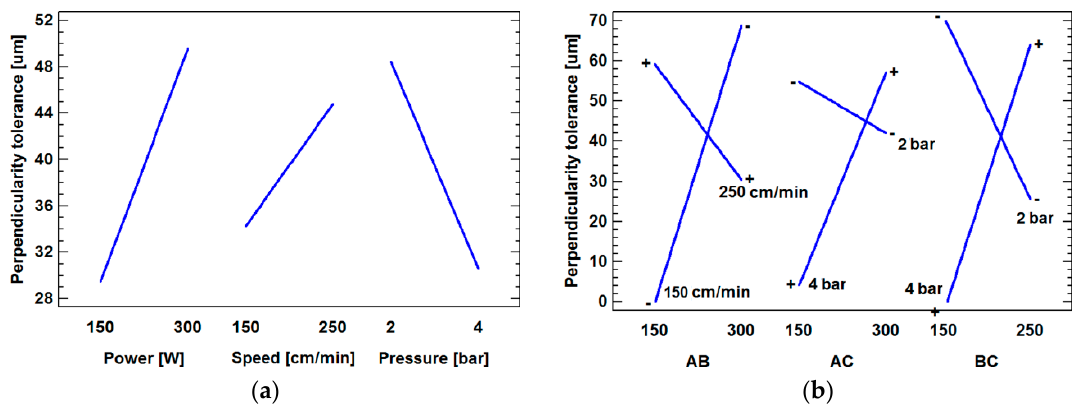
Figure 5. ( a ) Main effects and ( b ) interaction plots of perpendicularity tolerance. A: laser power; B: cutting speed; C: oxygen pressure. Polynomial trendlines have been used to fit perpendicularity tolerance data.